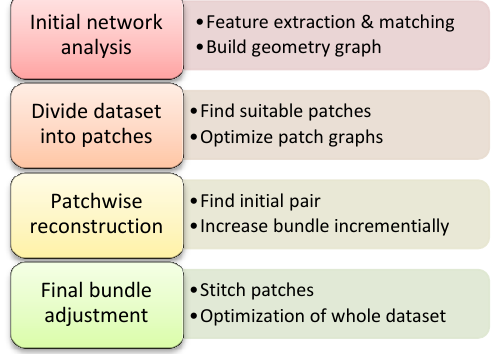
Figure 1. Flowchart for the presented